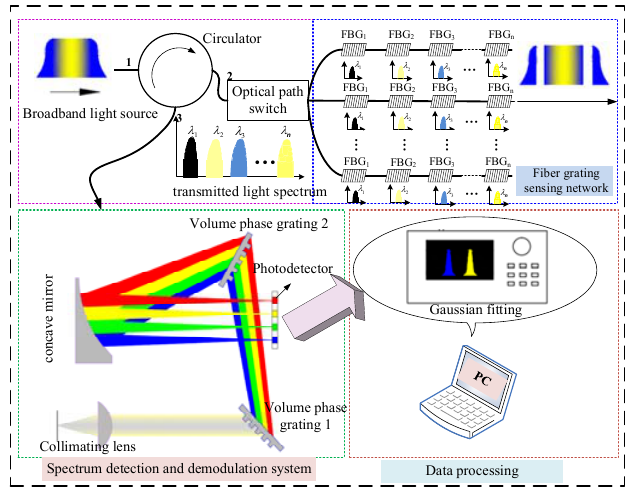
Figure 5. Wavelength demodulation principle and peak searching method.